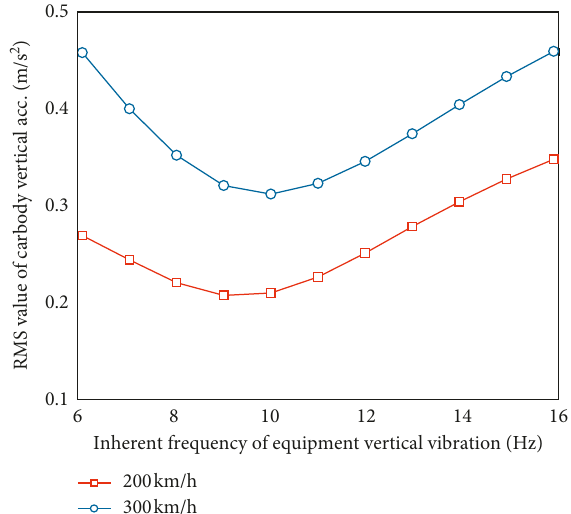
Figure 4: RMS value of the car body vertical vibration acceleration.